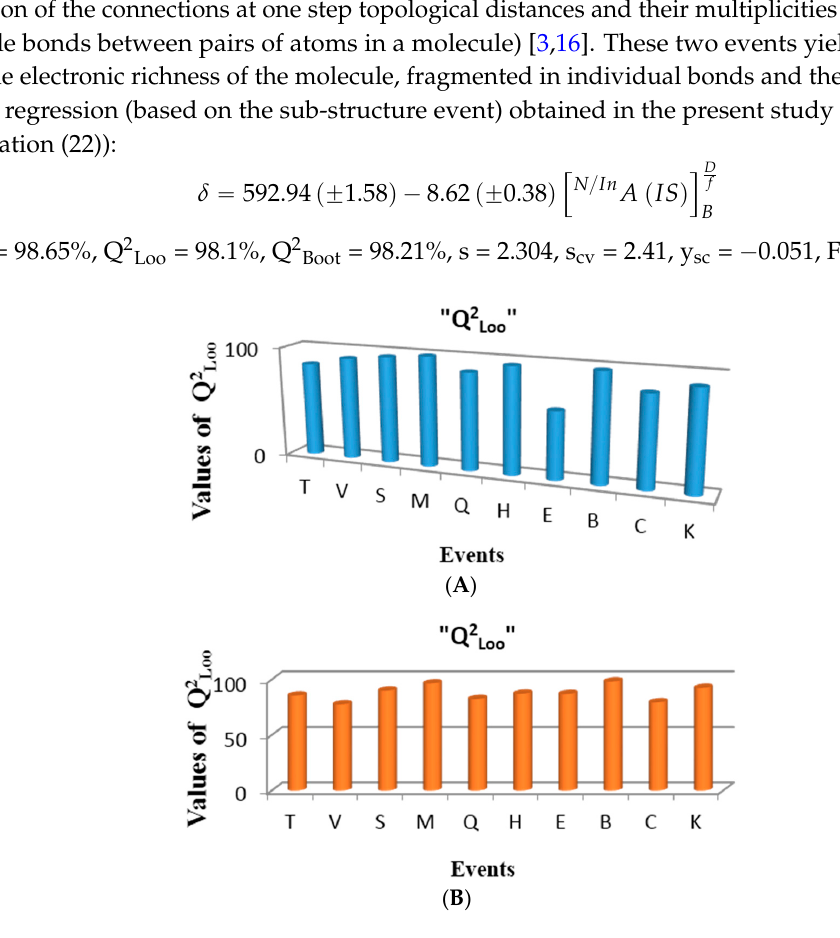
Figure 8. Development of the one-variable linear regression models obtained for each event: ( A ) Ethers; ( B ) Aldehydes and Ketones.